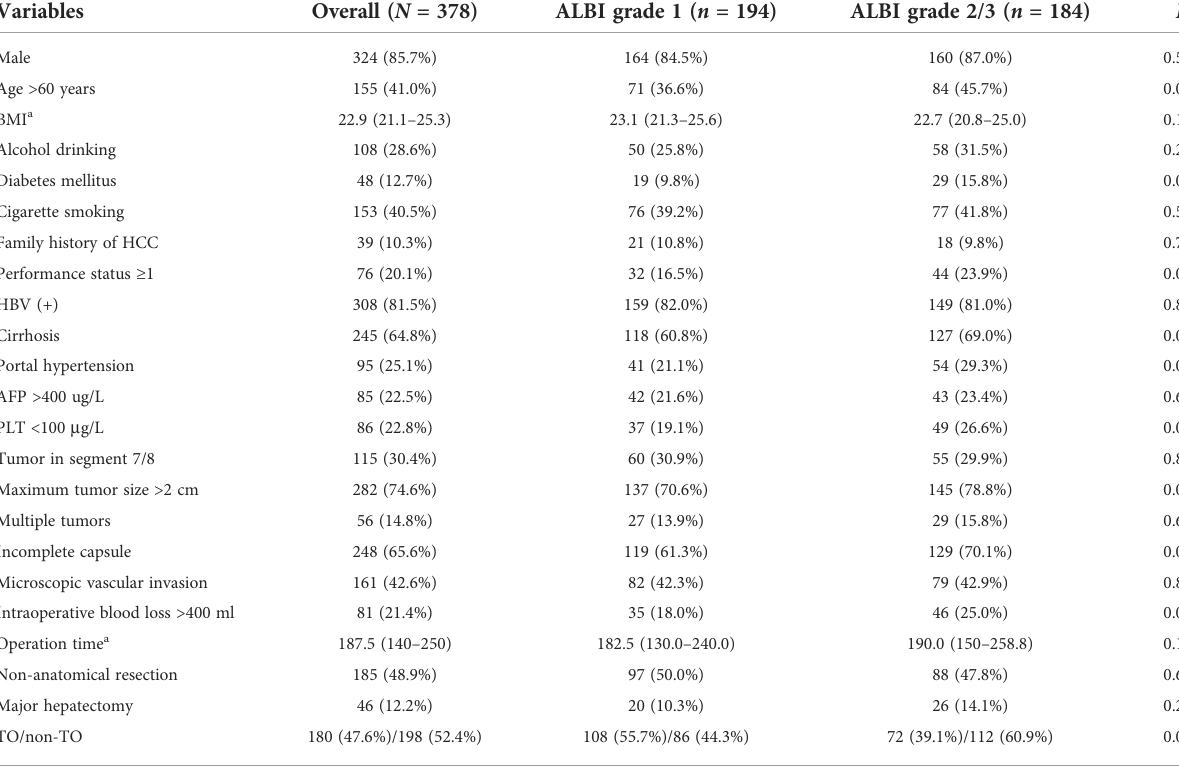
TABLE 1 Comparison of the clinical characteristics among the two groups according to preoperative albumin –